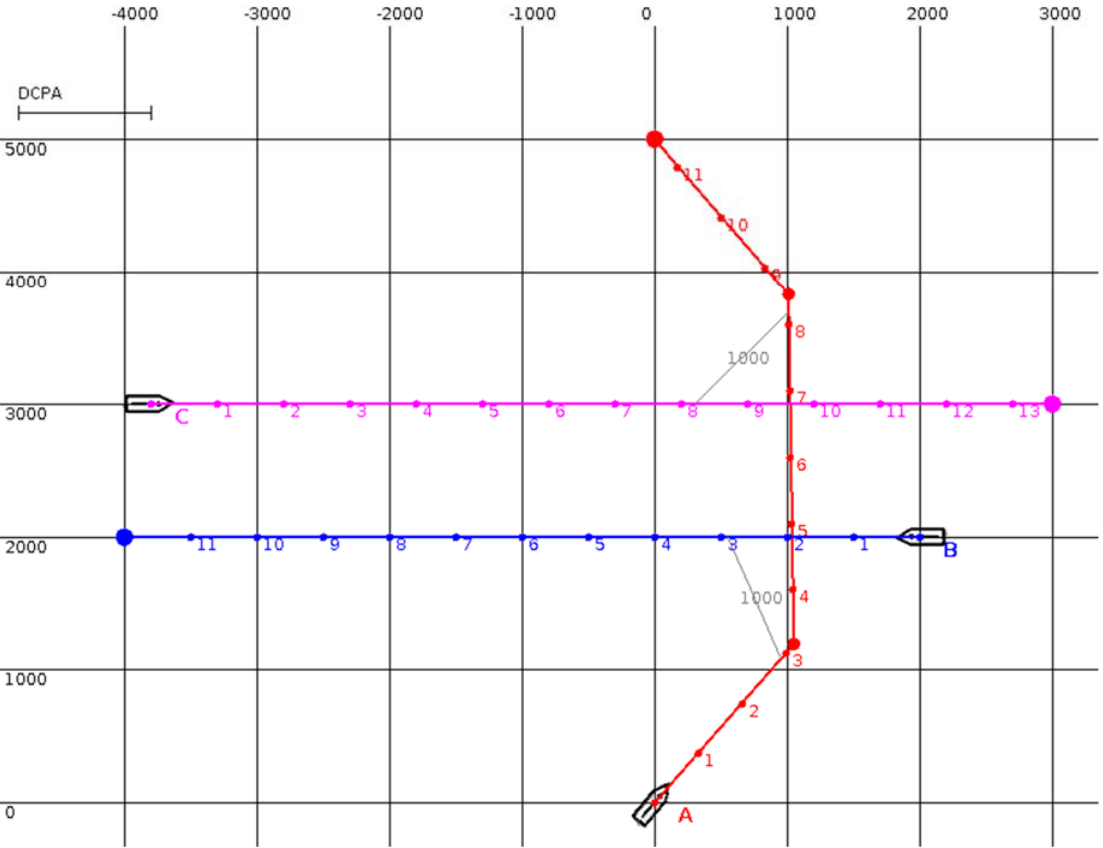
Figure 1. An encounter situation involving three surface vehicles (A, B, and C). The trajectories of surface vehicles B and C are marked in blue and pink, respectively. The anti-collision trajectory for surface vehicle A, generated by MBSA, is marked in